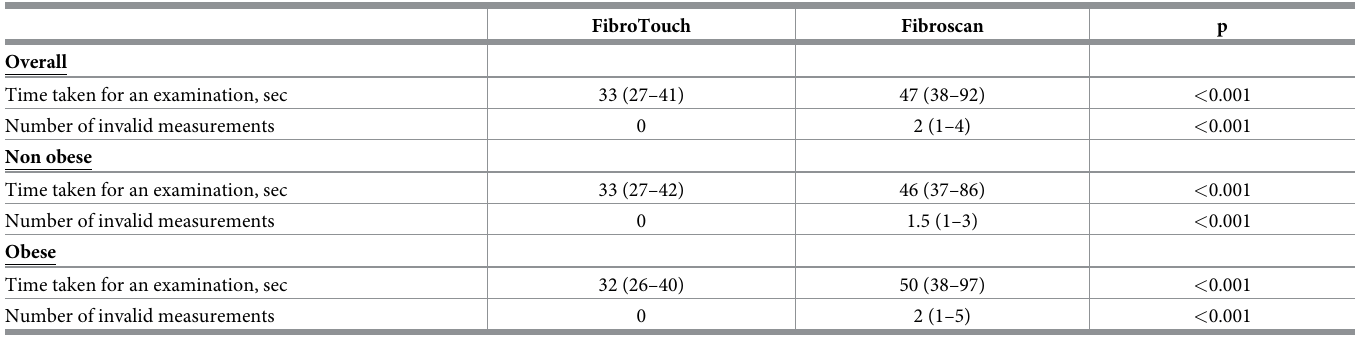
Table 3. Comparison of time taken for an examination and number of invalid measurements between Fibroscan and FibroTouch. FibroTouch